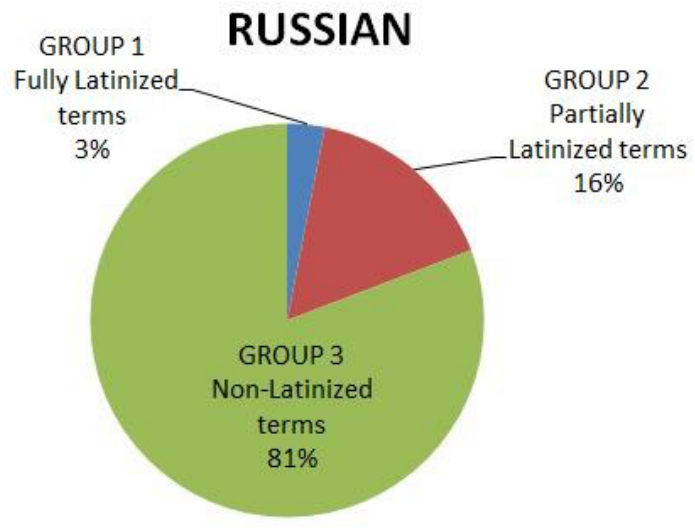
Figure 1 - The degree of Latinization of the Russian terms